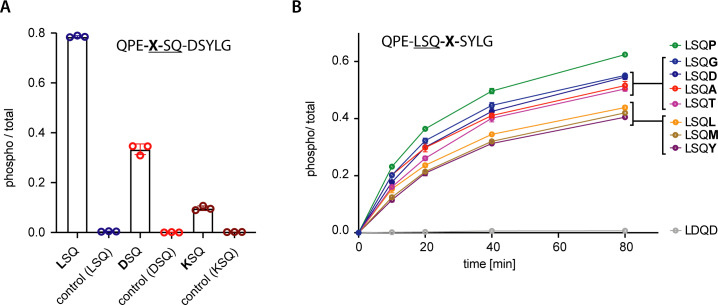
In vitro phosphorylation of UPF1-LSQ and derivatives.(A) Mass spectrometry-based end-point measurements of single peptides combined with a control. Data points corresponding to one experiment are shown in the same color. One preferred (LSQ) and two suboptimal (DSQ, KSQ) motifs were chosen to evaluate how the absence of more optimal, competing motifs affects phosphorylation efficiency toward single peptides. The results indicate that decreased phosphorylation of peptides with non-hydrophobic position −1 residues is not only caused by competition with more optimal substrates (compare assay shown in Figure 4B). A peptide with the sequence QPELDQDSYLG was used as a control in all three experiments. Reactions were quenched and analyzed after 80 min. The peptide sequence is shown with the varied position marked as ‘X’ (B) Mass spectrometry-based phosphorylation assay with UPF1-LSQ and derivatives varying in position +2. The peptide sequence is indicated with the varying position marked as ‘X’. Error bars representing standard deviations calculated from independent experimental triplicates are shown.